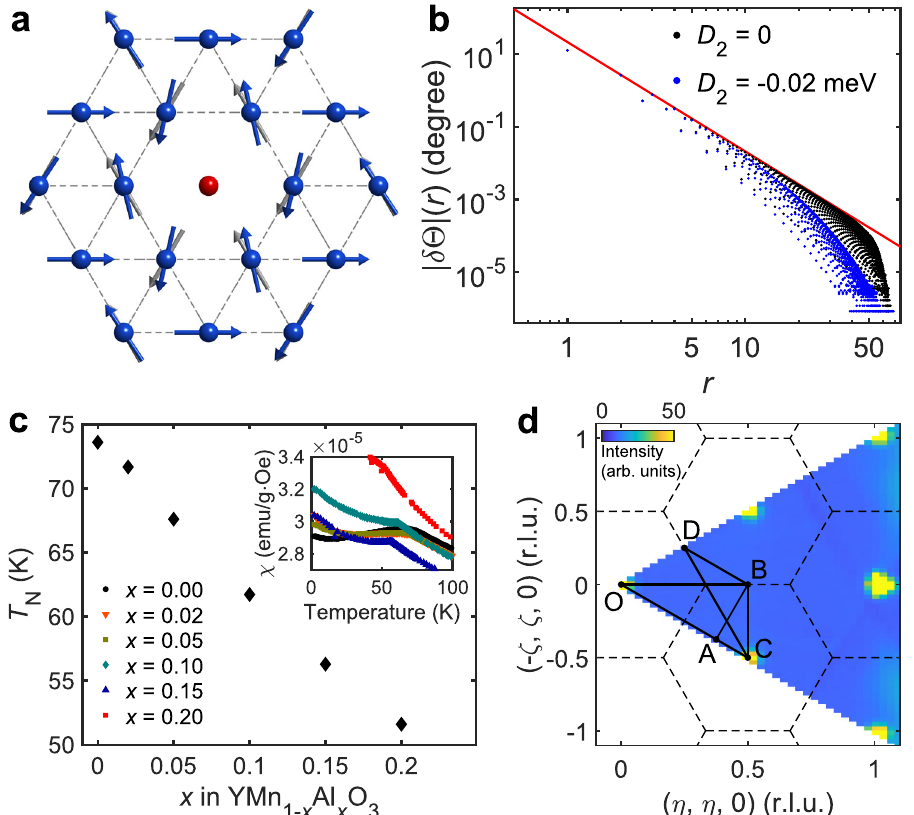
Fig. 1 Formation of a spin texture in 2D-TLAF h- Y(Mn,Al)O 3 . a Local spin canting induced by a vacancy in a triangular lattice antiferromagnet (blue arrows) and original 120 ◦ magnetic order (gray arrows). b Distance dependence of the canting angle j δΘ ð r Þj in the spin texture around a vacancy determined from the numerical simulations. Black (Blue) dots denote the simulation with D 2 = 0 ( − 0.02) meV, repectively. The red line is a guided plot of the 1/ r 3 behavior. c Doping dependence of the transition temperature T N . The inset denotes the magnetic susceptibility of YMn 1- x Al x O 3 as a function of temperature, from which the transition temperatures ( T N ) were determined. d Two-dimensional reciprocal space of YMnO 3 with the labels of high-symmetric points and the high-symmetric lines used in Fig. 2. Color plot shows magnetic Bragg peaks of h- YMn 0.85 Al 0.15 O 3 measured by neutron